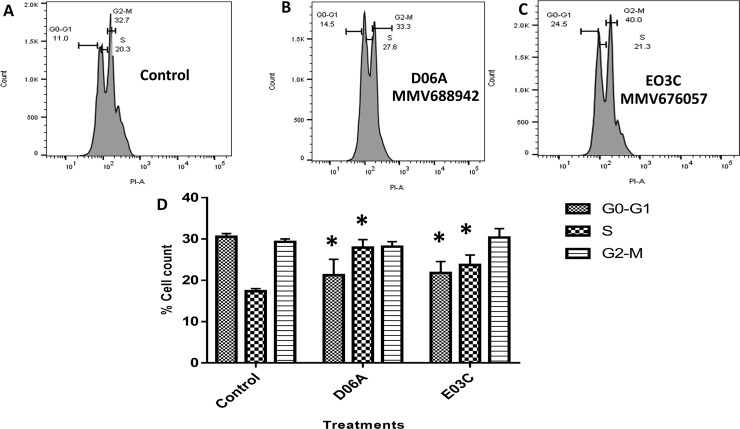
Cell cycle progression of Leishmania donovani treated cells.Flow cytometry histograms of (A) Untreated (B) MMV688942 (D06A) (2x IC50). (C) MMV676057 (E03C) (2x IC50). Parasites were cultured with compound for 24 hours. Untreated promastigotes cells were used as negative control. (D) The percentage quantification of cells at each cell cycle phase. Cell counts in treated wells were compared to those in untreated wells using Student’s t test, and statistical significance was set at P<0.05. Data shown are representative of three independent experiments.